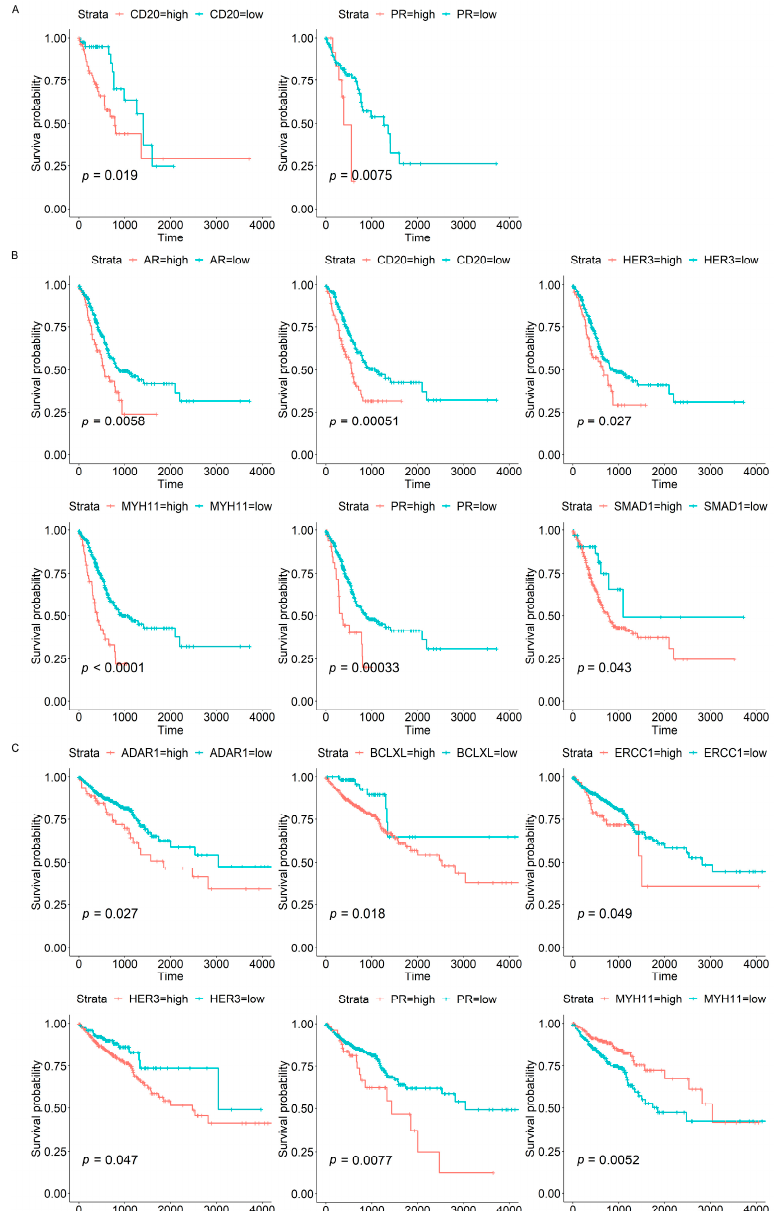
Figure 6. Kaplan ‒ Meier survival curves based on the candidate proteins: Kaplan ‒ Meier survival curves showed that ( A ) two candidate proteins, ( B ) six candidate proteins, and ( C ) six candidate proteins were associated with overall survival in ESCA, STAD, and CRC patients, respectively. The horizontal axis represents survival time in days, and the vertical axis shows the overall survival rate.